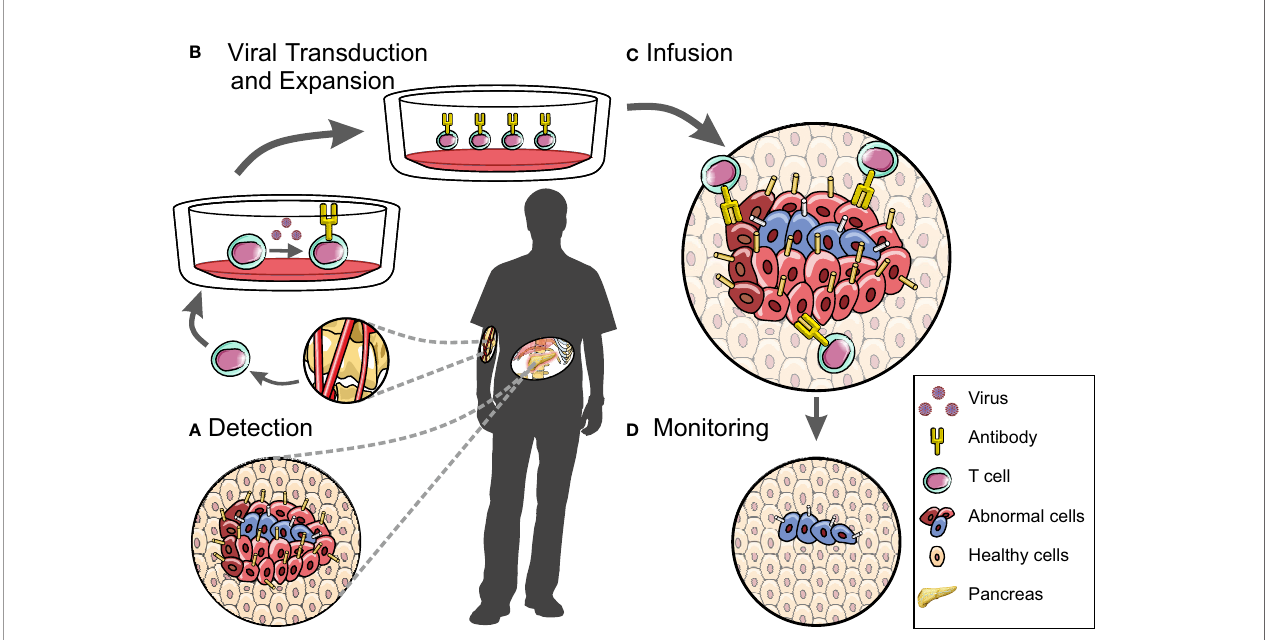
FIGURE 2 | A work fl ow for developing and administering cell therapy. CAR T cell-based therapies involve (A) the discovery of disease-associated antigens which can then be used to target the cytotoxic effects of engineered CAR T cells, (B) the isolation and manipulation of patient-derived T cell populations, (C) the infusion of these cells into patients, and (D) downstream monitoring of